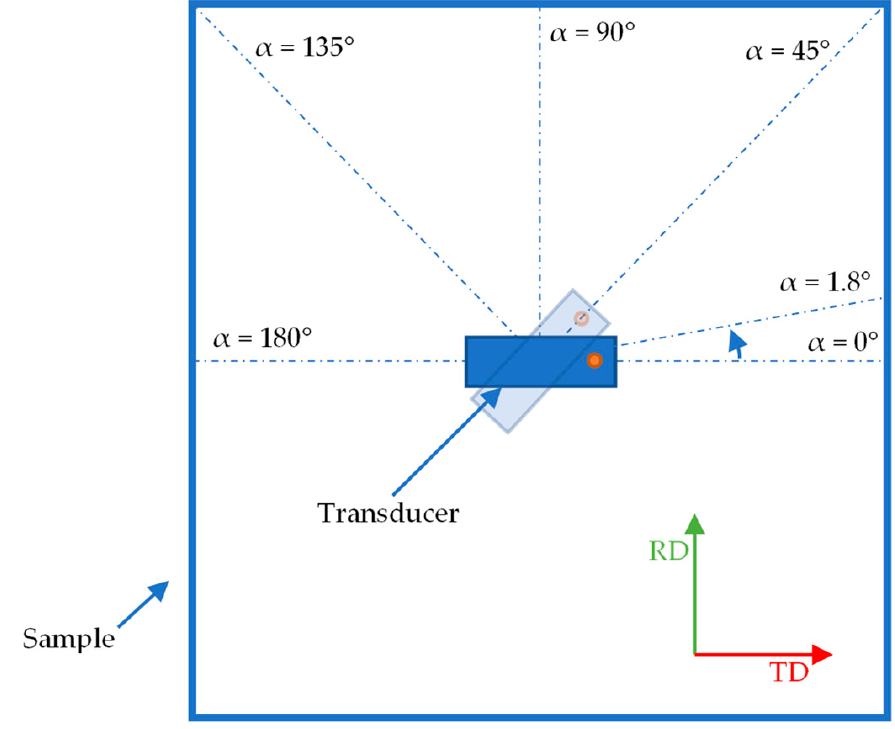
Figure 1. Diagram which illustrates: the sample, transducer, and depicts the direction of rotation, direction of the rolling axis (RD) and transvers direction (TD—it is perpendicular to the rolling axis). The measurements were fully automated. The positioning of the transducer and signal acquisition was managed by a computer. Signals were acquired and generated by the DAQ measurement card (NI-PCI-6251). The measurements were performed using a sinusoidal excitation wave with a frequency of 10 Hz. The excitation current was 370 mA, which corresponds to the value of approximately 1.6 kA/m of magnetizing field. A detailed description of the transducer and measuring system can be found in [19–21,28]. Before the data acquisition process, the signal was filtered using analog filters with the pass band set to the 2 kHz–100 kHz range. Detailed information on the filtration settings was provided by the authors in [21]. For each angle, 10 measurements were made, and for a